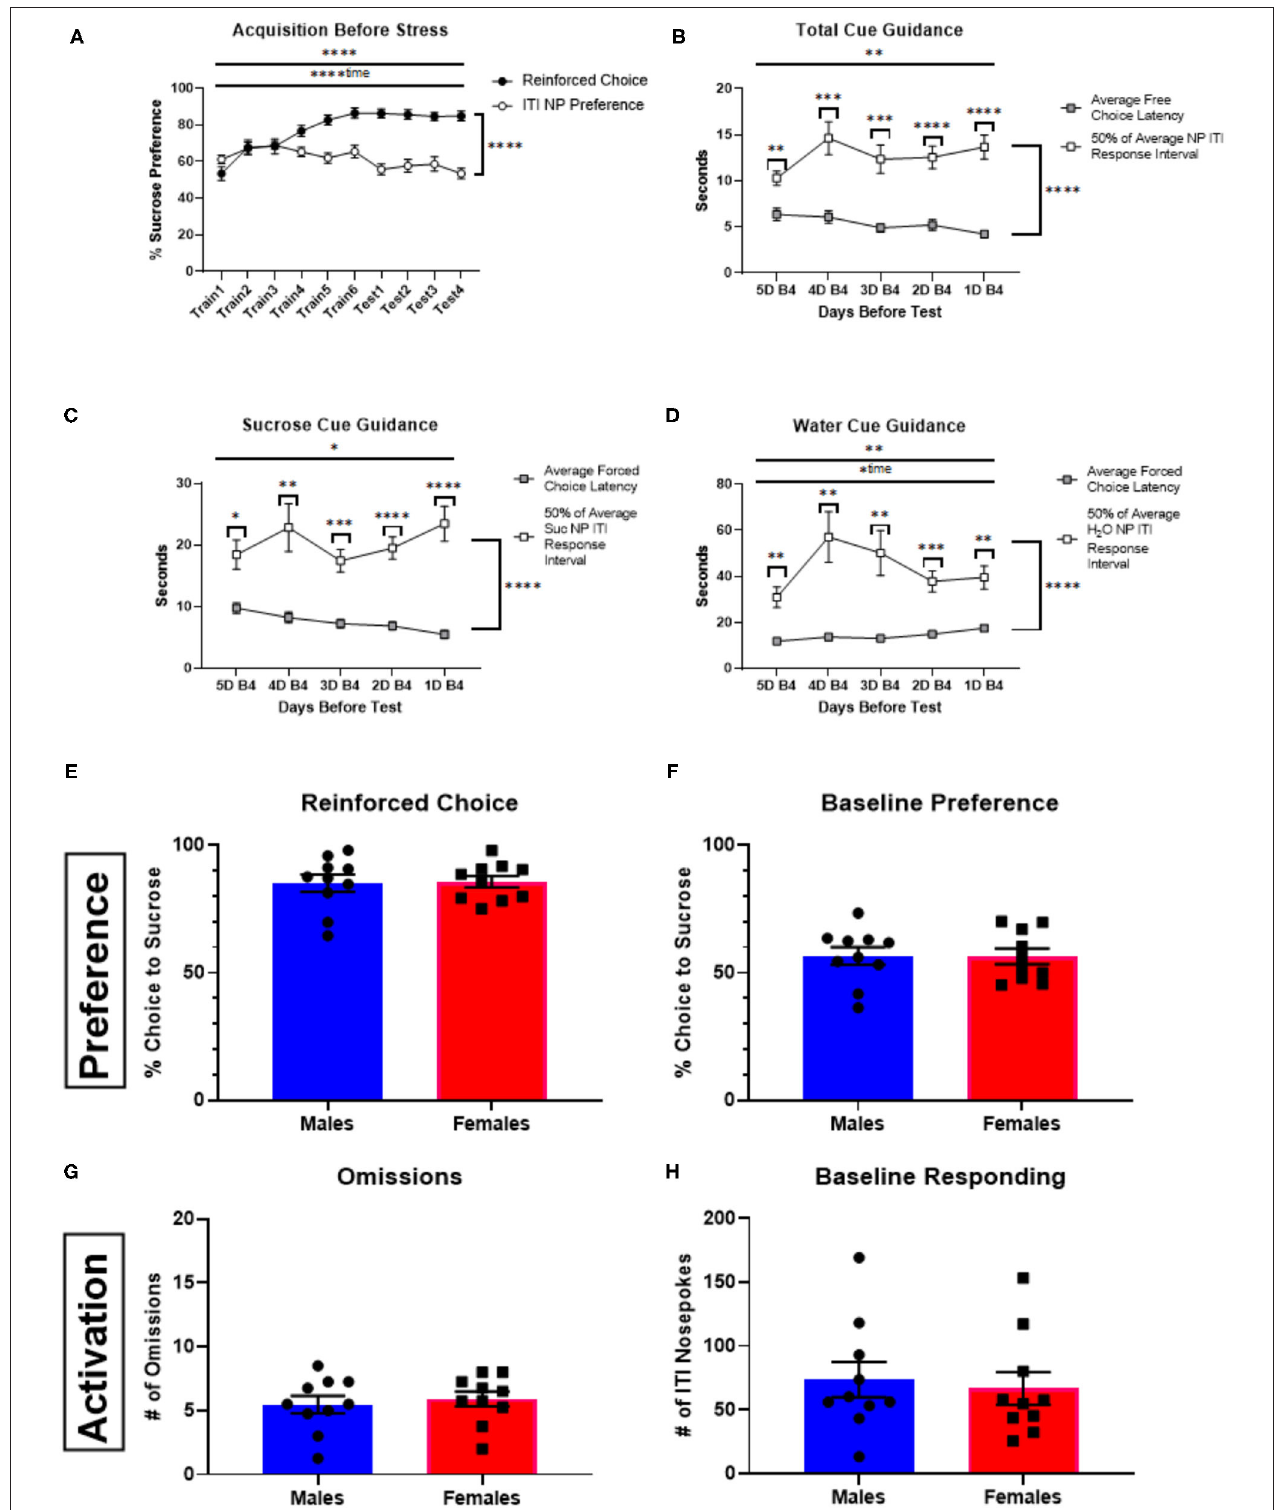
FIGURE 2 | Acquisition behavior, cue-guidance verification, and sex comparisons of behavior in a stress-naïve state. (A) Percent sucrose receptacle preference: reinforced choice percentage vs. baseline preference represented by nosepokes made during the ITI ( ± SEM) up to the day of stress (or no stress) for animals